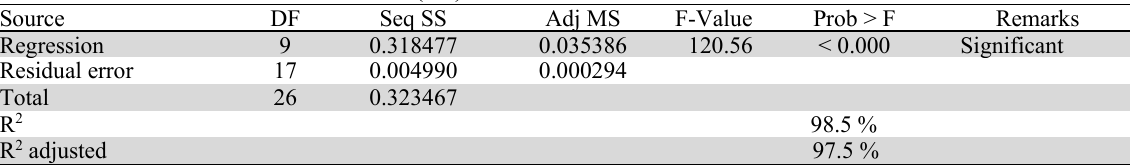
ANOVA table for the fitted models ( Ra ).